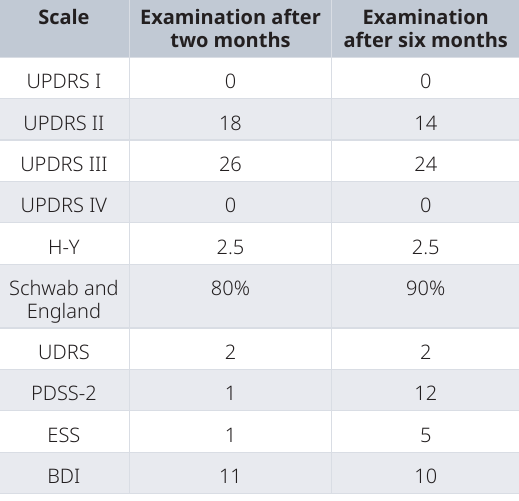
Table 1. Results of clinical assessments two and six months after therapy with dronabinol.